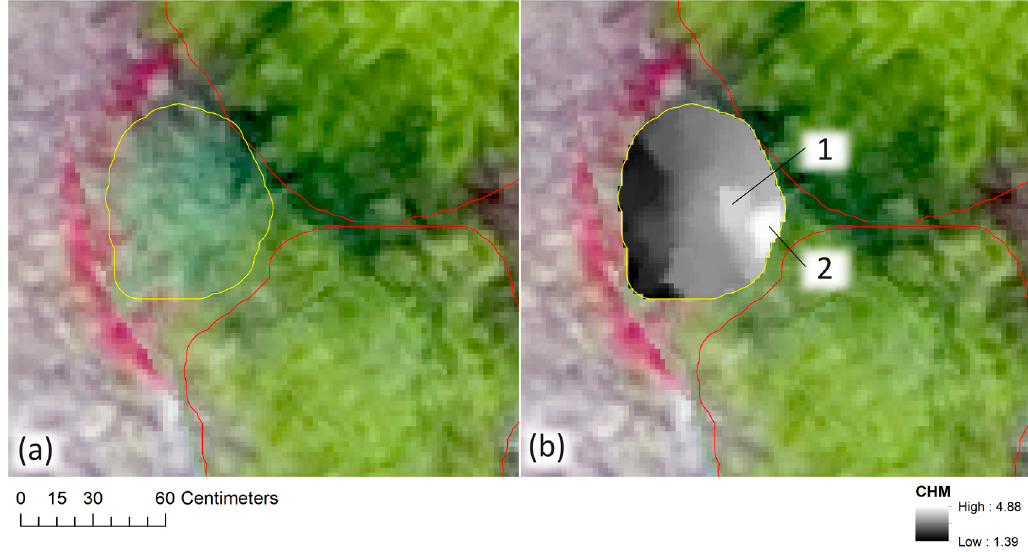
Figure 12. Predicted ITC polygon (yellow) whose remote height measurement overestimated its corresponding field measurement. ( a ) displays the polygon in true colour, while ( b ) shows canopy height models (CHM) values within the polygon. The numbered labels in ( b ) refer to two distinct clusters of high CHM values found within the polygon. The maximum CHM value within the polygon is contained in Cluster 2, which overestimates the polygon’s corresponding field height measurement by 0.70 m. The greatest CHM value contained in Cluster 1 is 0.20 m greater than the polygon’s corresponding field height measurement.